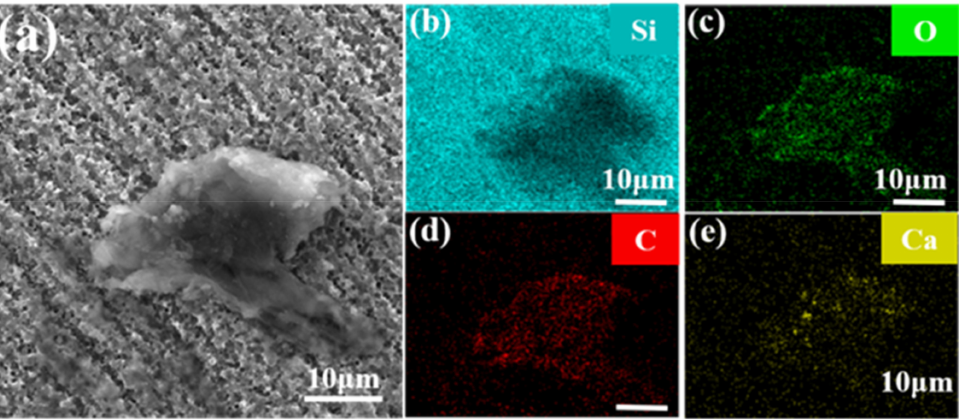
Figure 8. ( a ) SEM image of white-spot-stained silicon wafer after etching, ( b ) elemental distribution of Si, ( c ) O, ( d ) C, and ( e )